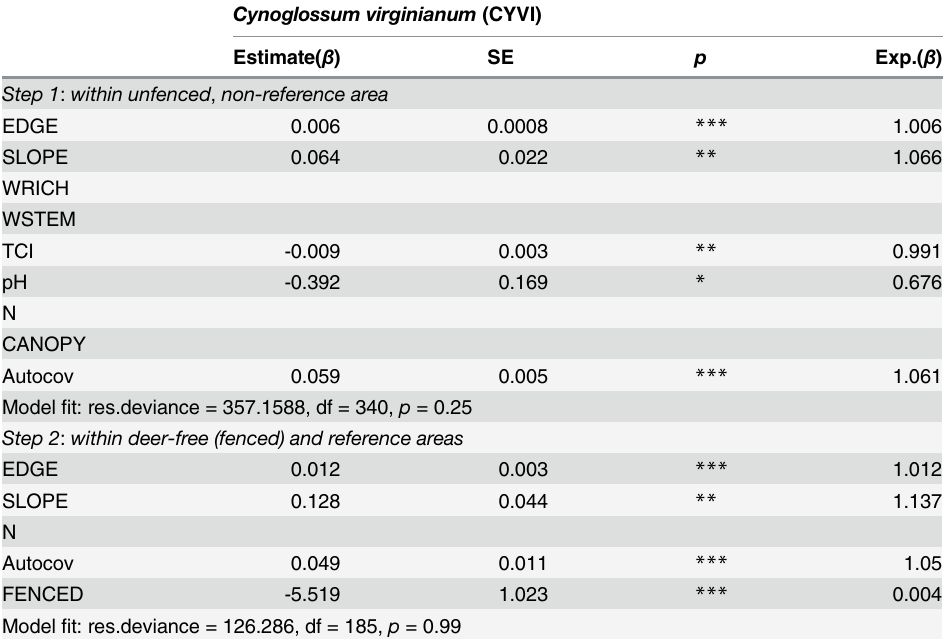
Table 2. Parameter estimates, standard errors and p -values ( *** < 0.001, ** < 0.01, * < 0.05,. < 0.1) for final generalized linear models estimating the effects of site covariates on the abundance of native Cynoglossum virginianum in the SCBI forest